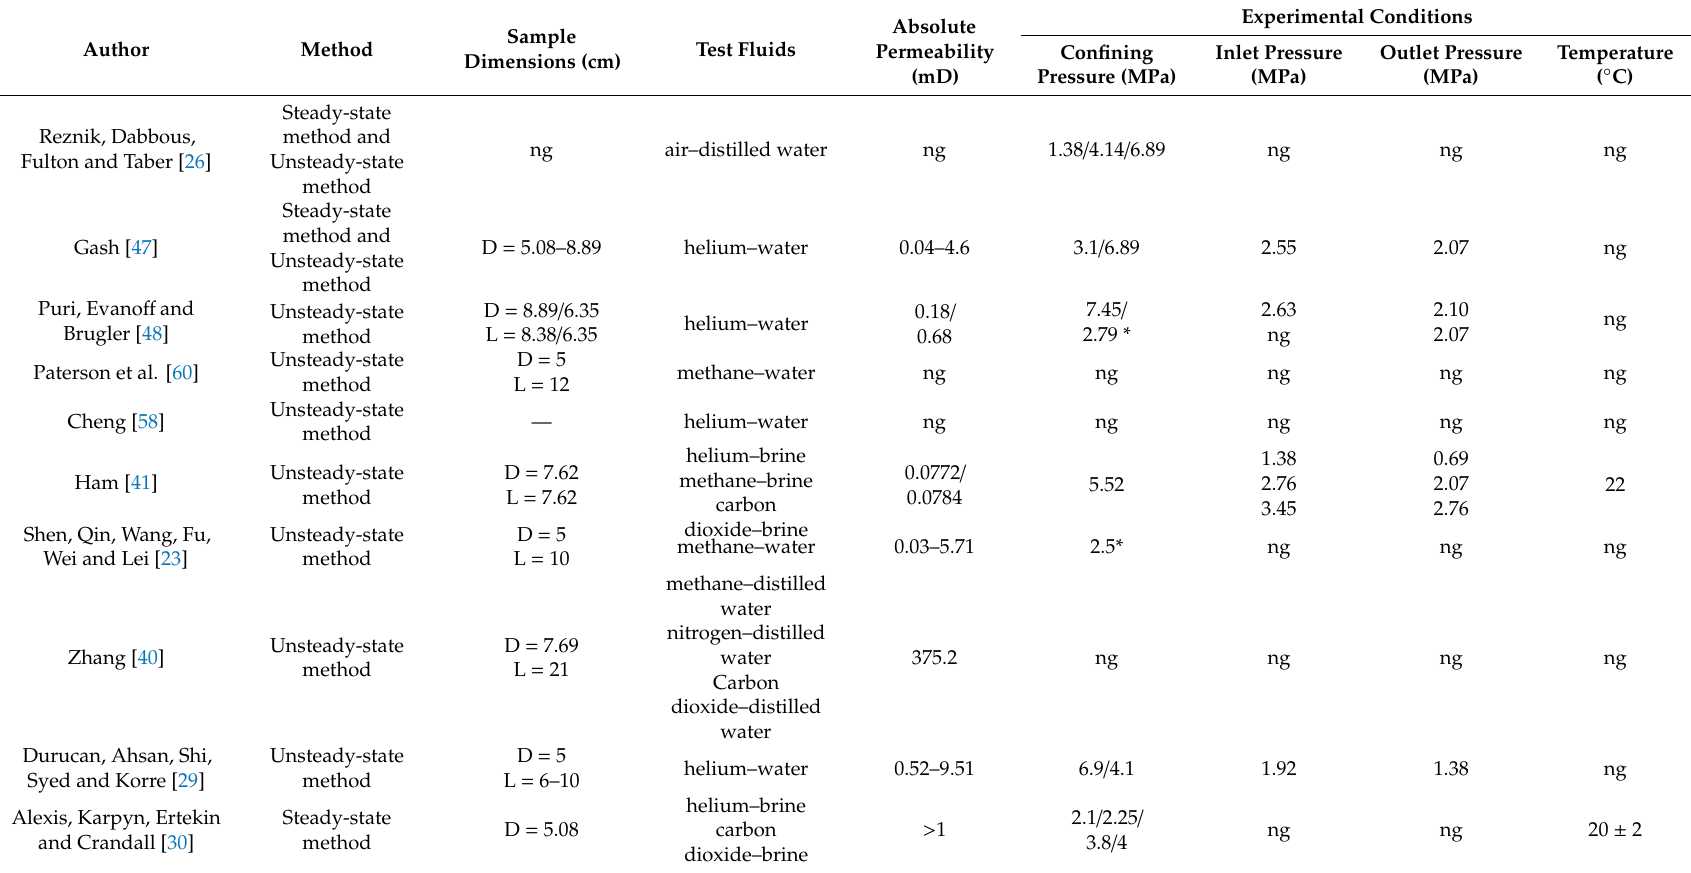
Table 1. Summary of the experimental conditions designed by di ff erent authors with their self-developed experimental equipment. “*” represents the net confining pressure; “ng” means not